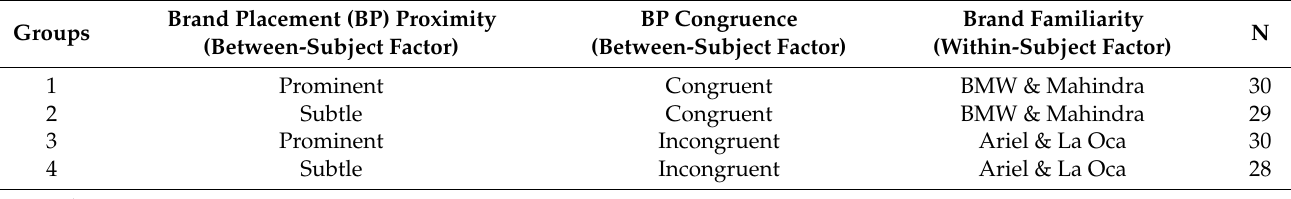
Table 3. Itemization of experimental